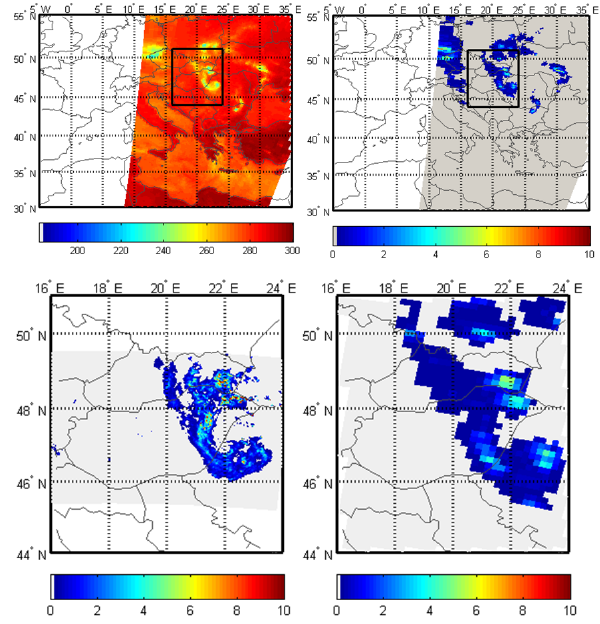
Figure 10. Thunderstorms over Hungary, 30 July 2011, 08:24UTC. Top panels: map of MHS (MetOp-A) TB (K) at 150GHz (left), and PNPR surface precipitation rate (mmh − 1 ) (right) (rectangles show the approximate area covered by the radar measurements). Bottom panels: detail of radar rainfall rate estimates (mmh − 1 ) (for the area in the rectangles shown in top panels) obtained from the Hungarian radar network at 08:30UTC (left panel), and PNPR surface precip- itation rate (mmh − 1 ) (right) at